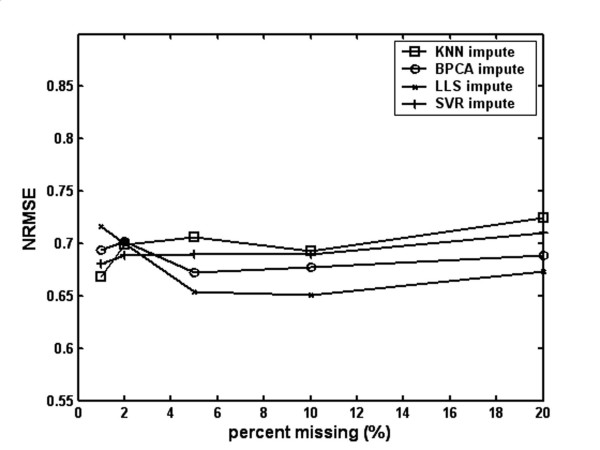
Performance of the four methods on data P.